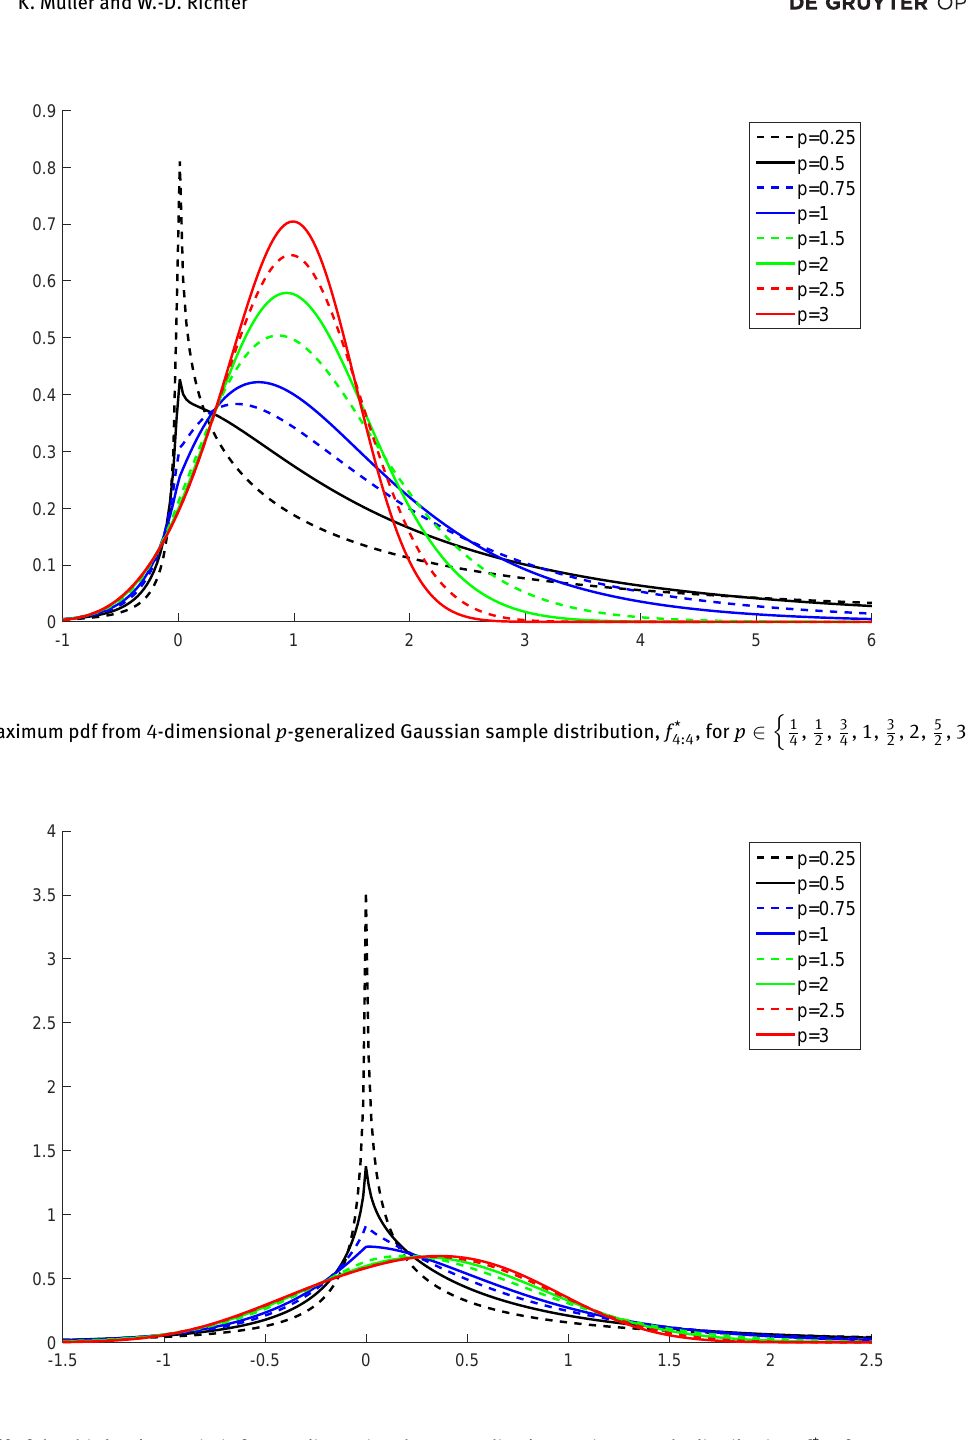
Figure 6: Pdf of the third order statistic from 4 -dimensional p -generalized Gaussian sample distribution, f * (cid:111) (cid:110) 1 , 1 , 3 , 1, 3 , 2, 5 , 3 4 2 4 2 2